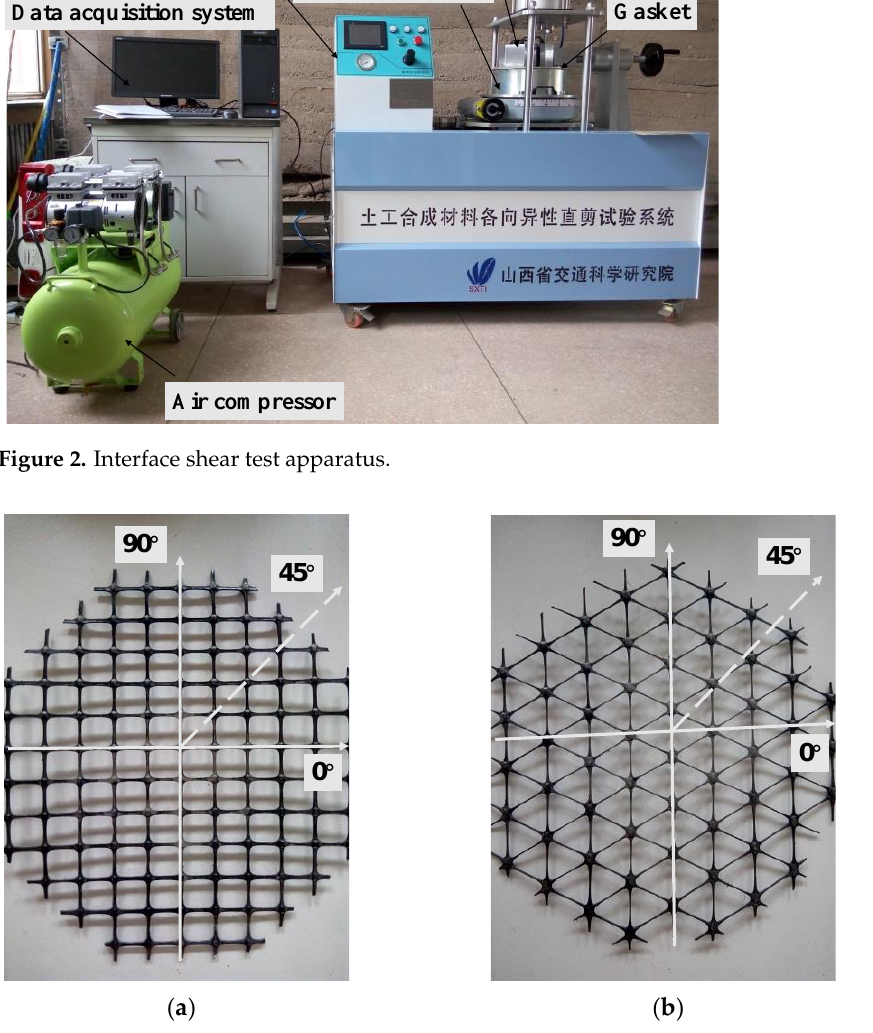
Figure 3. Geogrid specimen and shear direction. ( a ) Biaxial geogrid, ( b ) triaxial